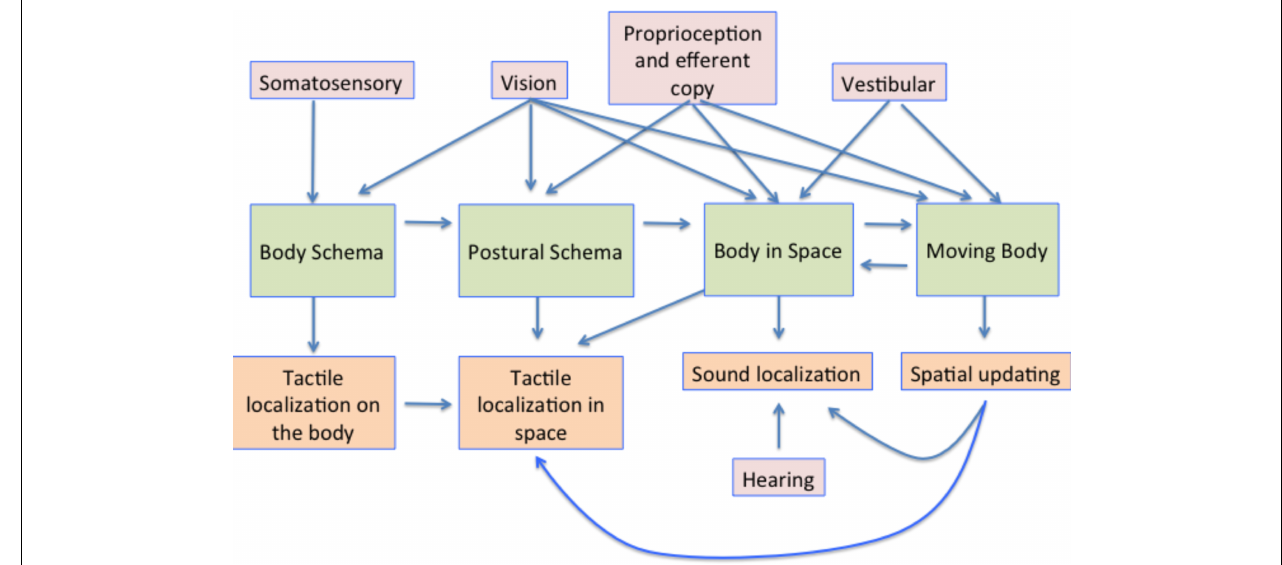
FIGURE 8 | A summary model of the multisensory contributions to the multiple representations of the body in the brain and how they influence aspects of perception. The pink boxes show the sensory contributions to the